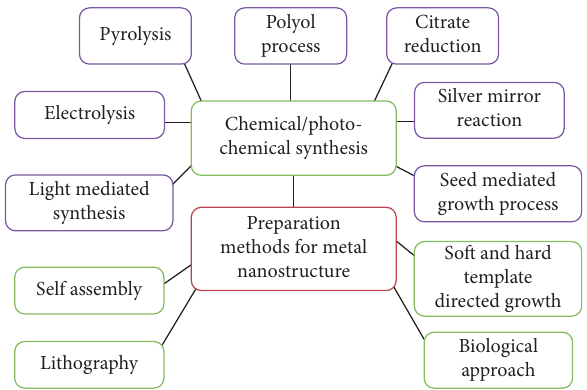
Figure 1: Different methods of synthesis of metal nanostructures